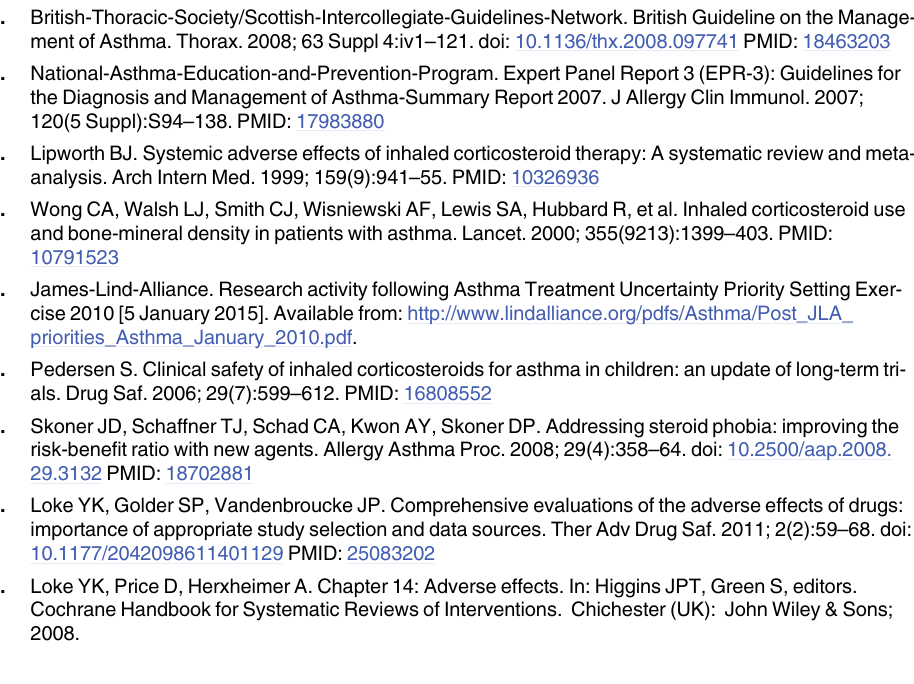
S1 Fig. Flow Diagram of process of study selection.